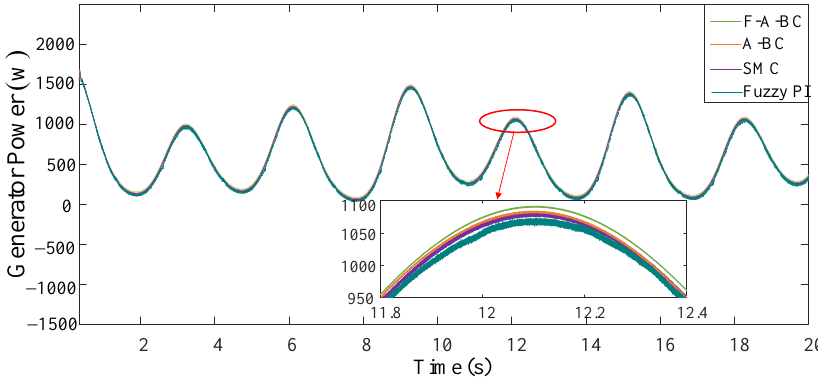
Figure 6. The generator power under swell effect.